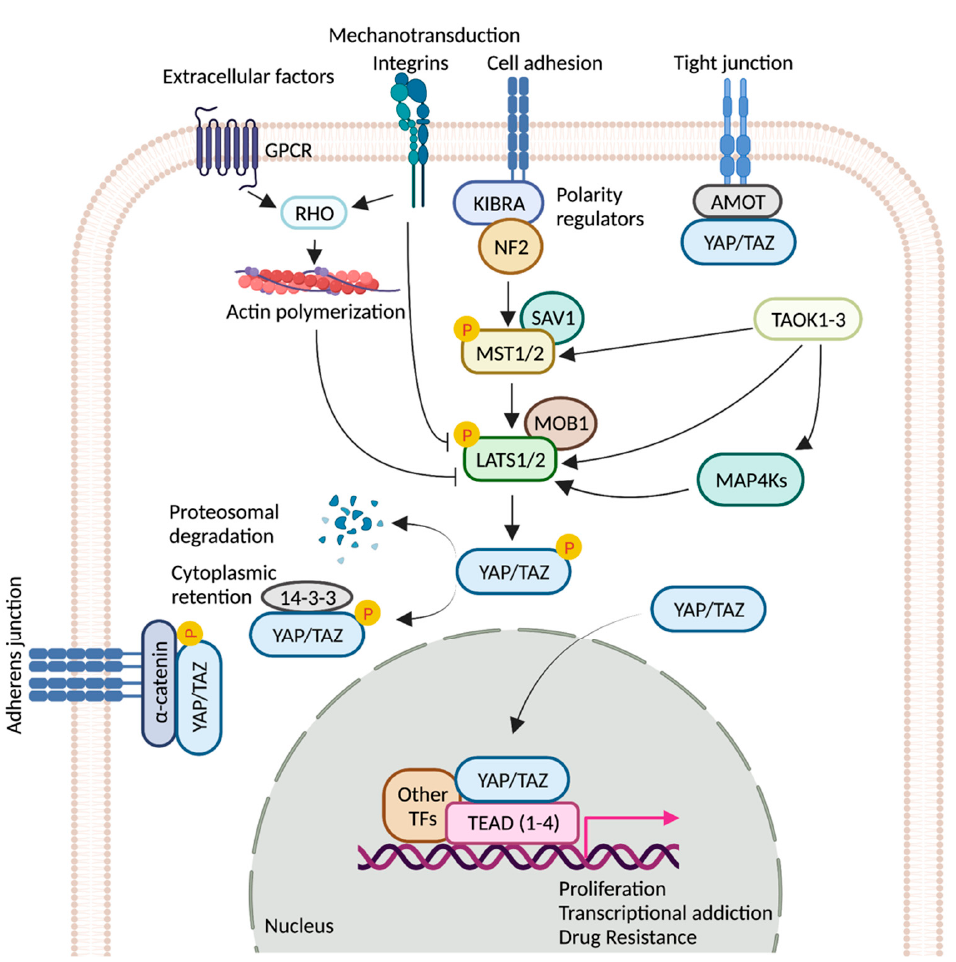
Figure 1. Regulation of YAP/TAZ activity by key signaling events. Schematic representation of the core components of the Hippo pathway. When the pathway is ON, a cascade of core kinases, composed of MST1/2 and LATS1/2, trigger phosphorylation of YAP/TAZ, which results in degradation or cytoplasmic retention of YAP/TAZ by 14-3-3. Various other signaling pathways and upstream effectors such as GPCRs (G protein-coupled receptors), TAOK family kinases, cell polarity, and adhesion regulators influence the activity of YAP/TAZ [4–7]. Mechanical cues relayed by extracellular-matrix-binding integrins and GPCR-mediated actin polymerization can inactivate the pathway. Unphosphorylated YAP/TAZ translocate into the nucleus, where it interacts with TEAD(1-4) and other cofactors. Together, they fuel the expression of pro-tumorigenic genes that can contribute to metastasis, transcriptional addiction, and drug resistance. Figure created with BioRender.com.